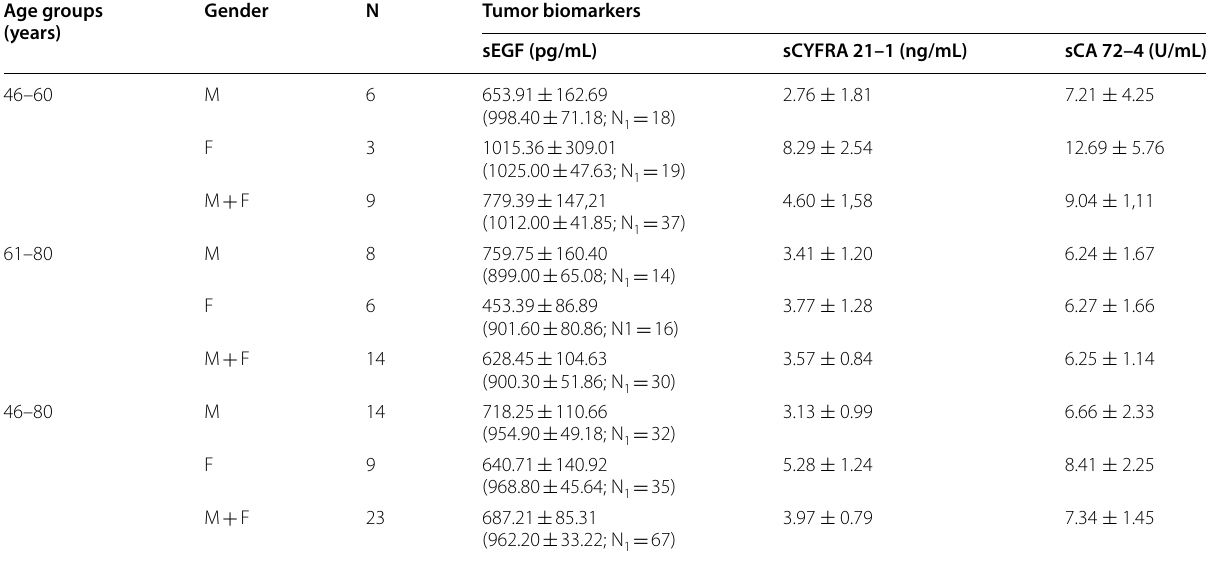
Table 2 Mean standard error of the mean of sEGF, CYFRA21-1, and CA 72–4 tumor marker values for apparently healthy subjects ± and newly diagnosed lung cancer adult patient